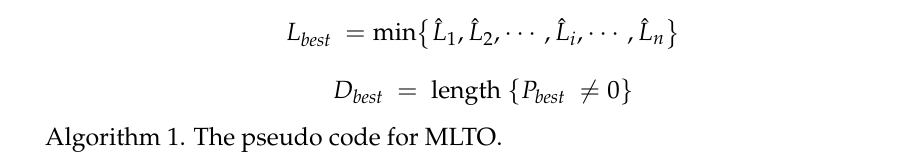
Algorithm 1. The pseudo code for MLTO. Algorithm 1. Mutual learning-based Trajectory Optimization